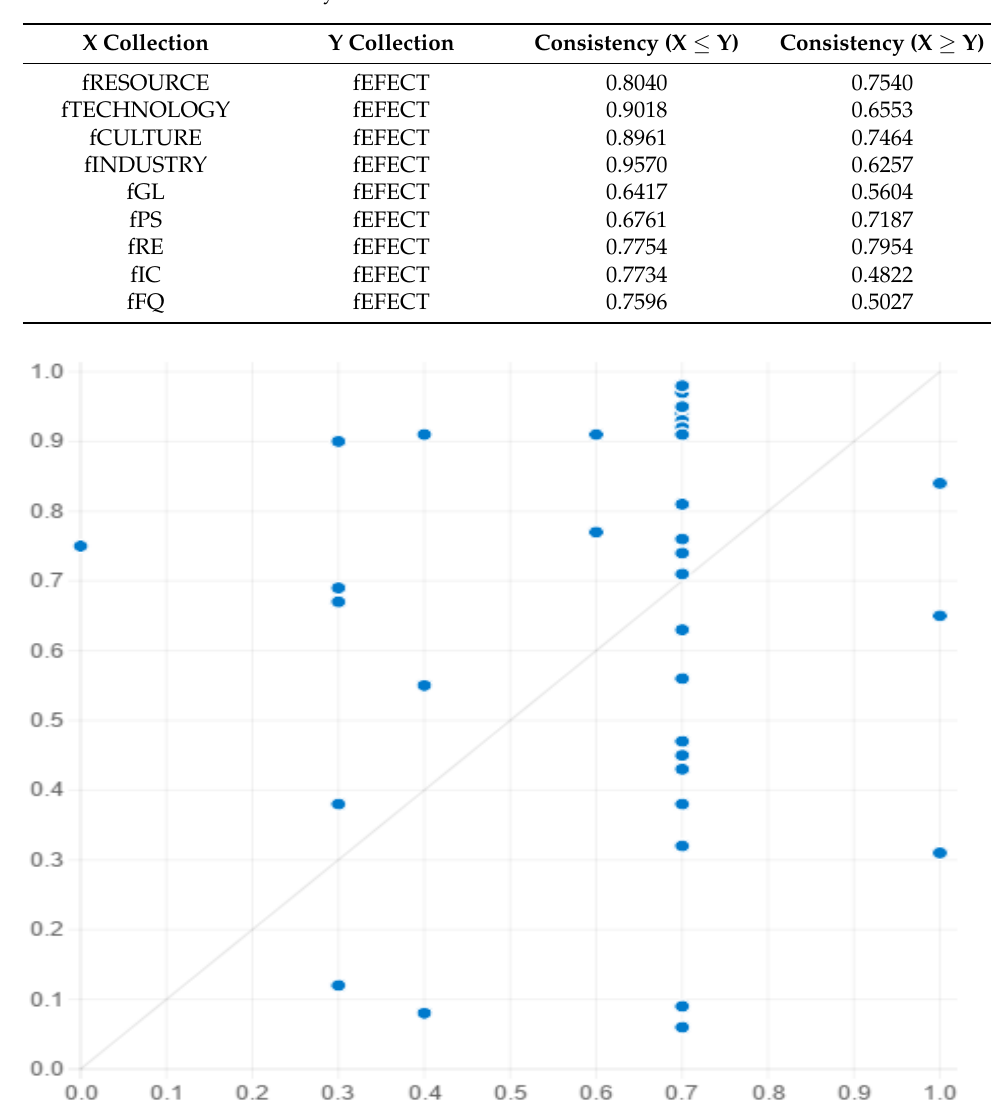
Table 2. Results of the causality test.